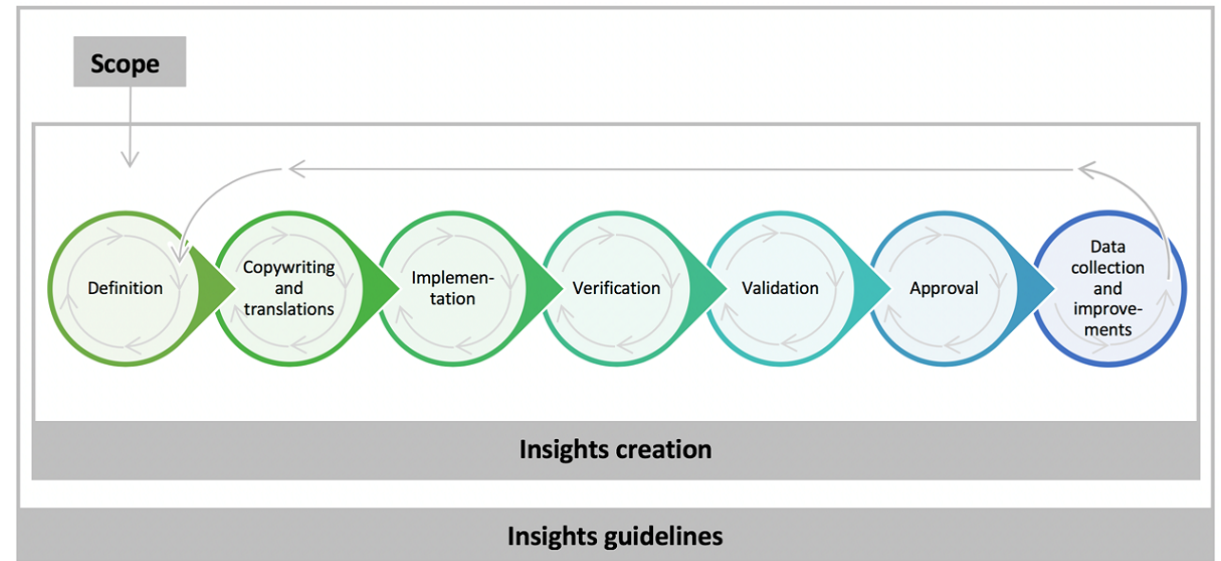
Figure 1. Insights development